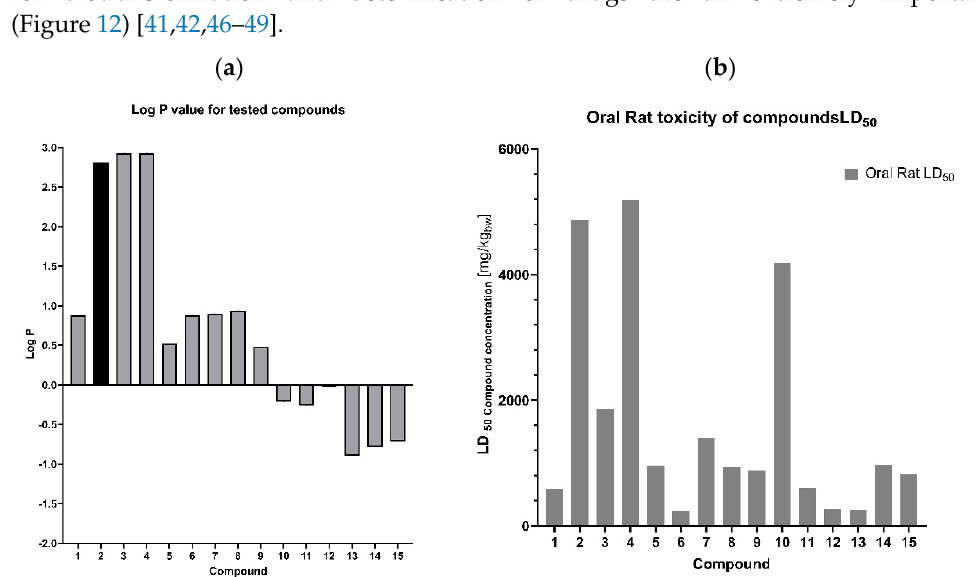
Figure 11. In silico prediction of lipophilicity ( a ) and toxicity ( b ) for fluconazole ( 1 ), lactones ( 2–4 ) and fluconazole analogues ( 5–15 ).